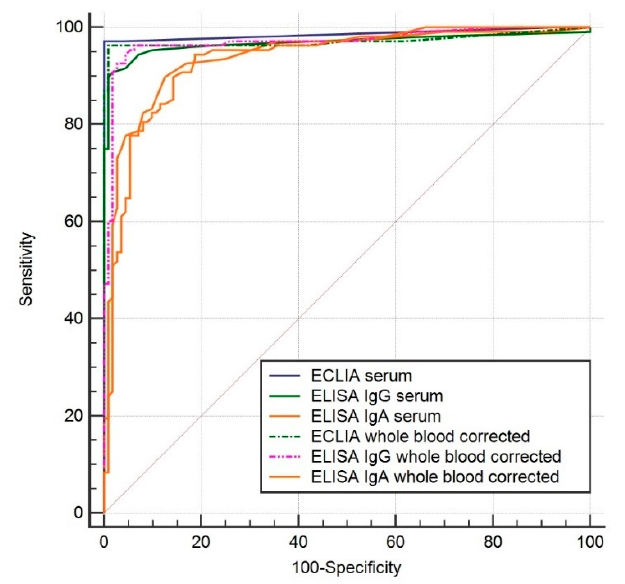
Figure 2. Diagnostic accuracies of the three different assays for COVID-19 identification in serum and whole blood corrected for hematocrit.